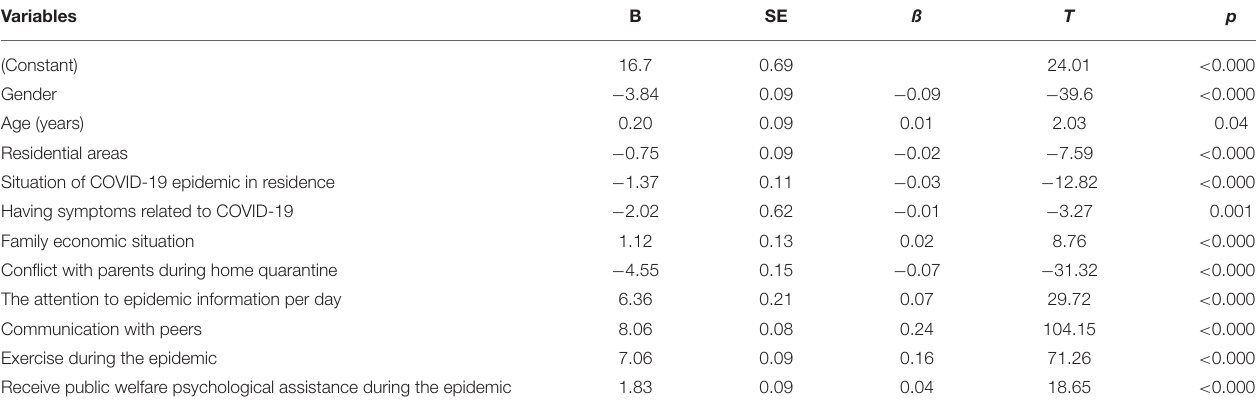
TABLE 5 | Results of multiple linear regression analysis of influencing factors for PTG.